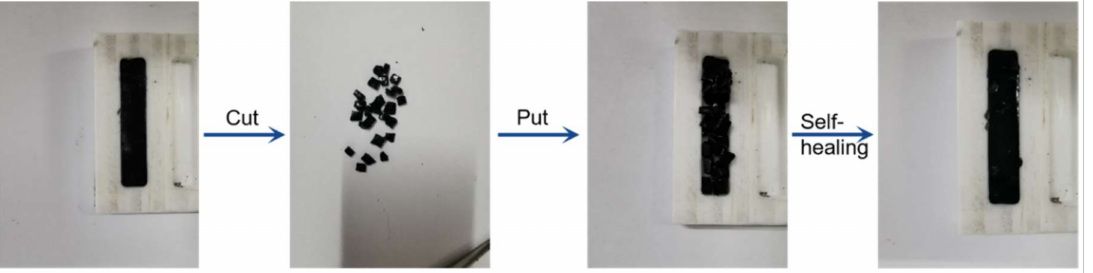
Figure 13. Self-healing process of